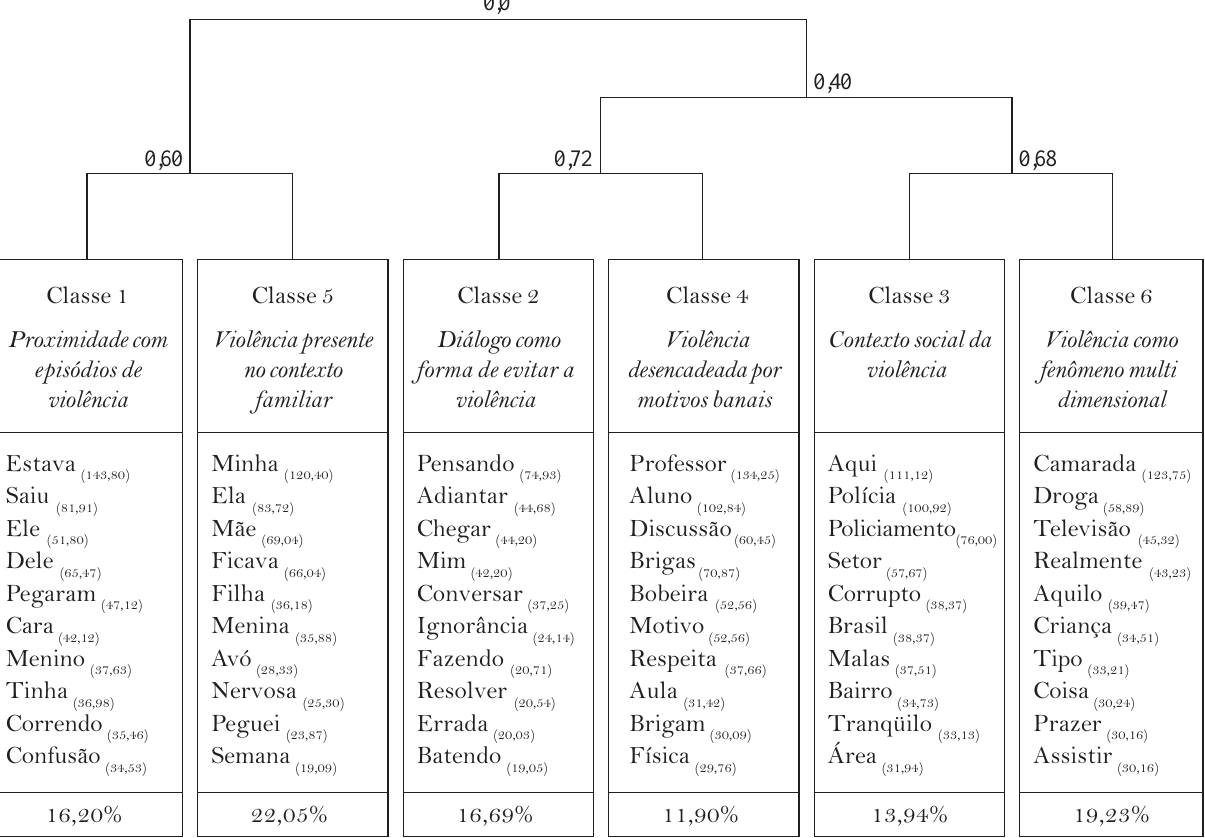
Figura 1. Campo comum da representação social da violência elaborada por adolescentes, organizado em seis